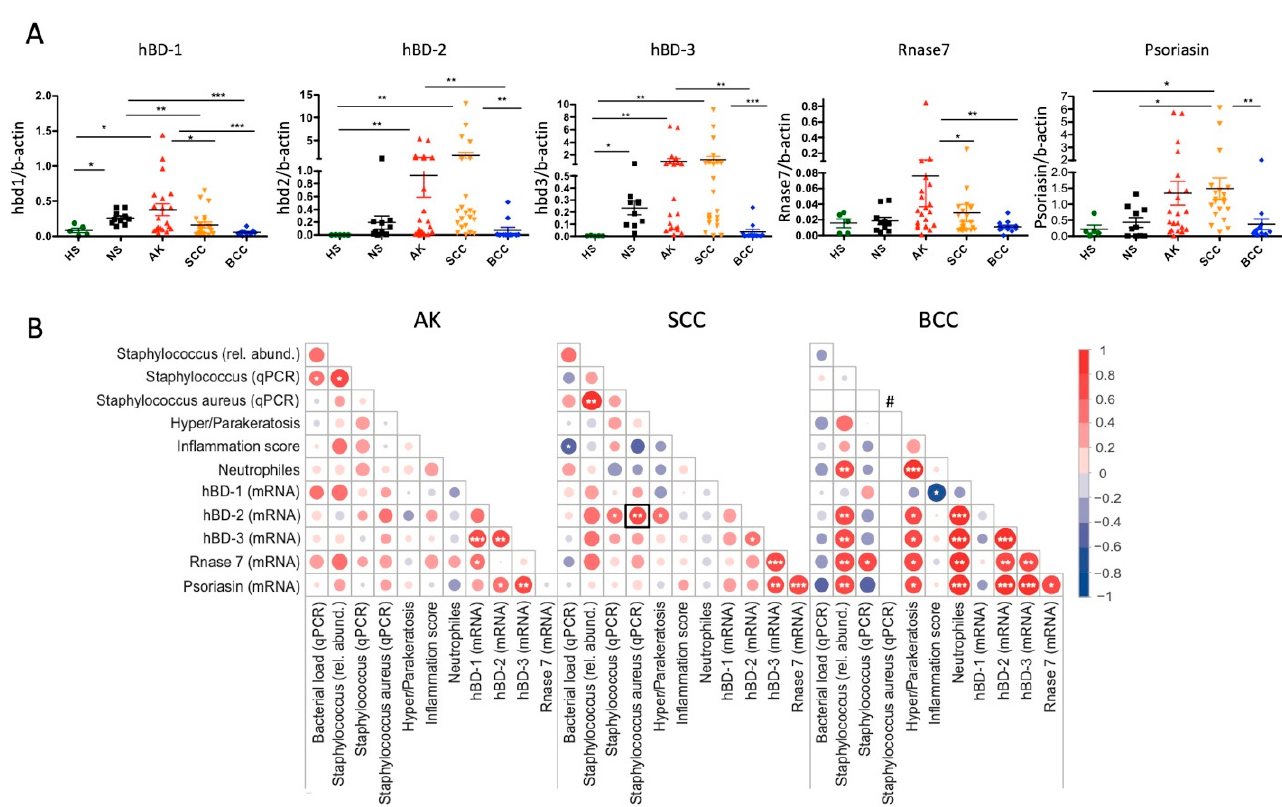
Figure 5. Antimicrobial peptide mRNA expressions and feature correlation analysis. ( A ) Transcription levels of hBD-1 and Rnase 7 were significantly increased in AK. A marked increase of hBD-2, hBD-3 , and to a lesser extent also of psoriasin mRNA was found in SCC and AK compared to BCC and normal skin (* p < 0.05, ** p < 0.05, *** p < 0.005, Kruskal–Wallis; HS, n = 5; NS, n = 10; AK, n = 21; SCC, n = 22; BCC, n = 11; data are mean ± SEM). ( B ) Pearson correlation matrix of assessed features in AK, SCC, and BCC. Strong correlations are indicated by large circles, whereas weak correlations are indicated by small circles. The color of the scale bar represents the nature of correlation with 1 indicating a strong positive correlation (dark red) and -1 representing a strong negative correlation (dark blue). t -tests to the individual correlations were applied for significance testing and significant correlations were indicated with * p < 0.05, ** p < 0.05, *** p < 0.005; shown as stars in the respective circles). The significant correlation of S. aureus loads with hBD-2 mRNA expression in SCC is highlighted (box); # denotes that no S. aureus signals were detected in BCC with qPCR.